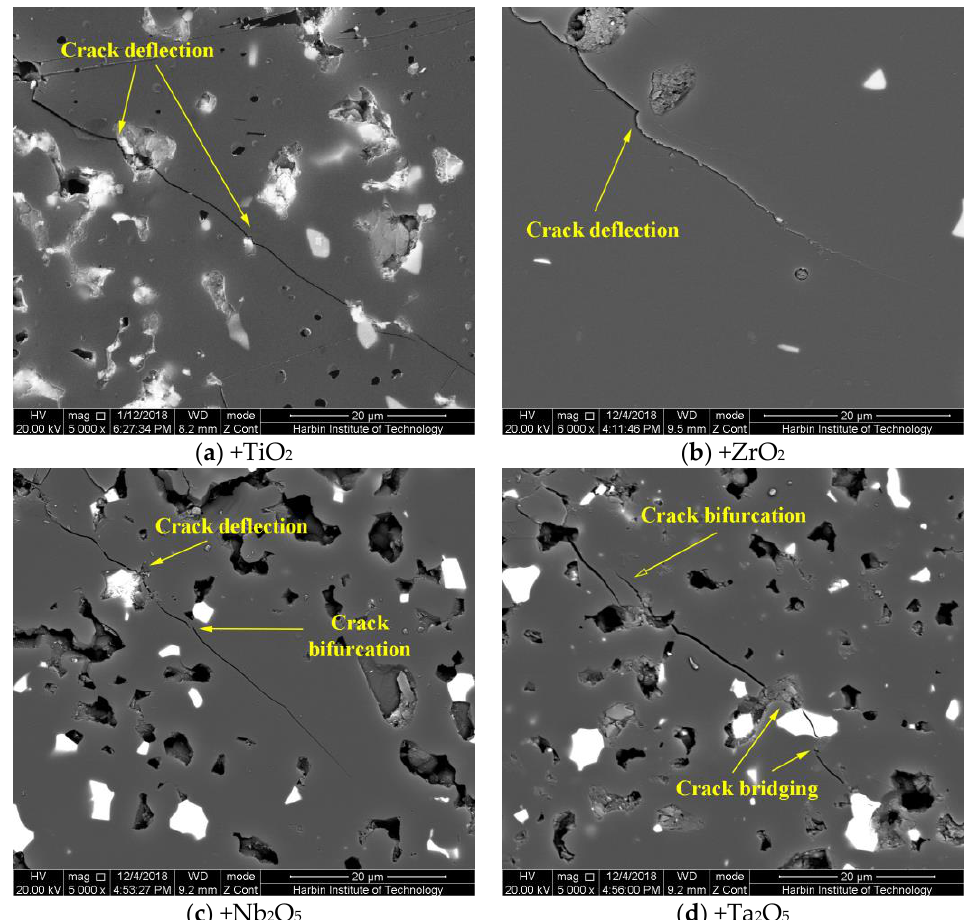
Figure 5. The results of SEM analysis of fracture surfaces and crack propagation of final products: ( a ) + TiO 2 ; ( b ) + ZrO 2 ; ( c ) + Nb 2 O 5 ; ( d ) + Ta 2 O 5 .